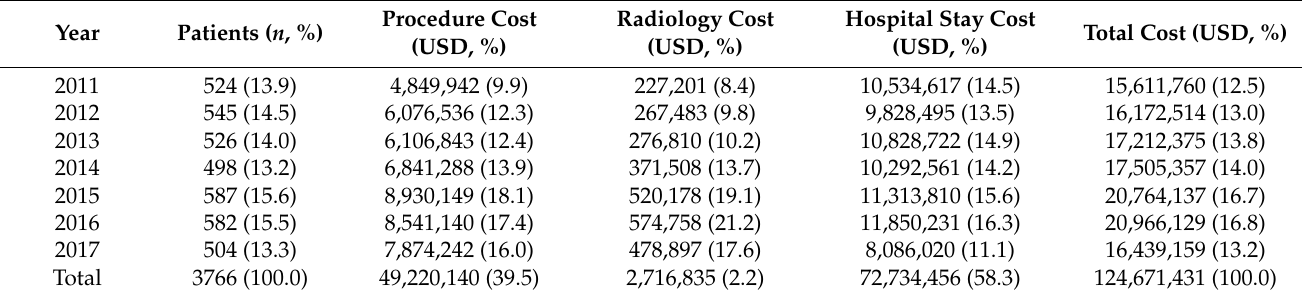
Table 4. Costs associated with work-related injuries by year, Hamad Trauma Center, Qatar (2011–2017) ( n =